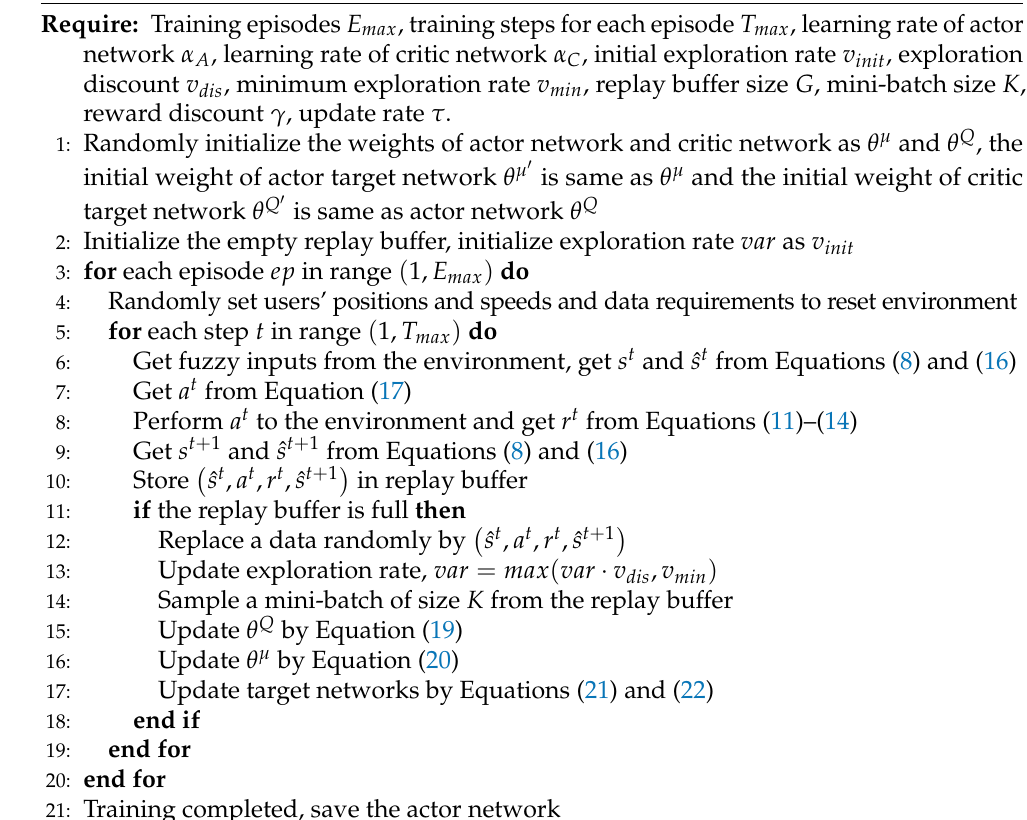
Algorithm 1. Fuzzy reinforcement learning training